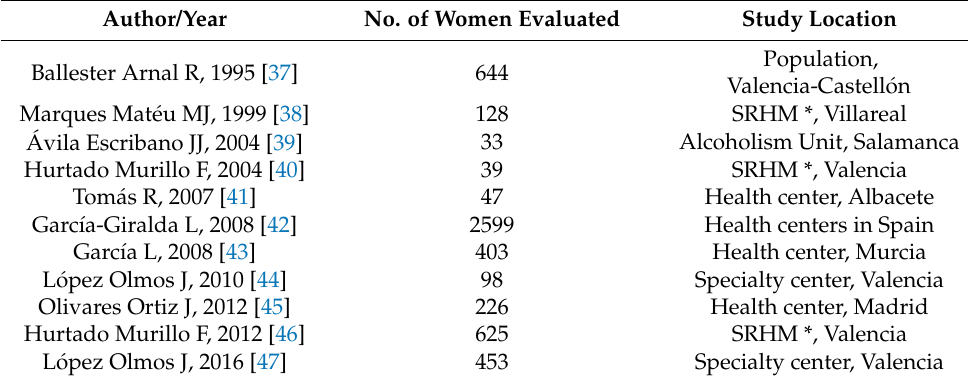
Table 1. Studies of GPPPD.